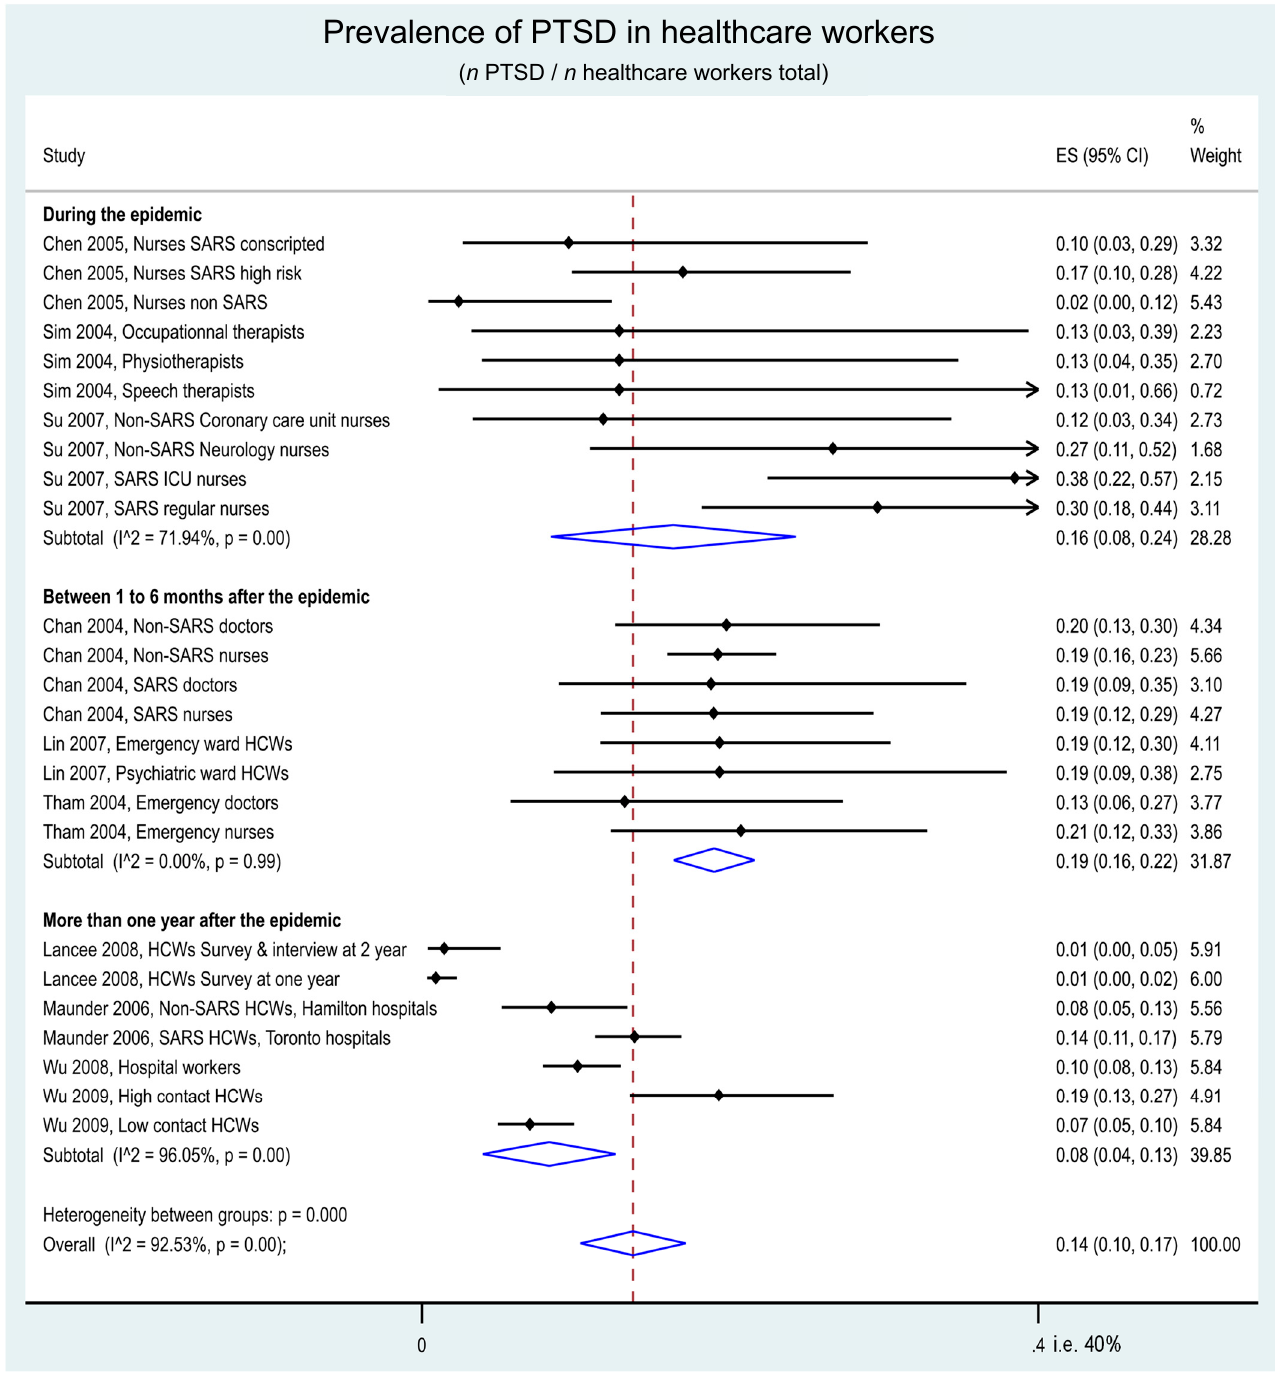
Figure 3. Meta-analysis on prevalence of post-traumatic stress disorder following the SARS-CoV-1 epidemic of 2003, by period of follow-up.